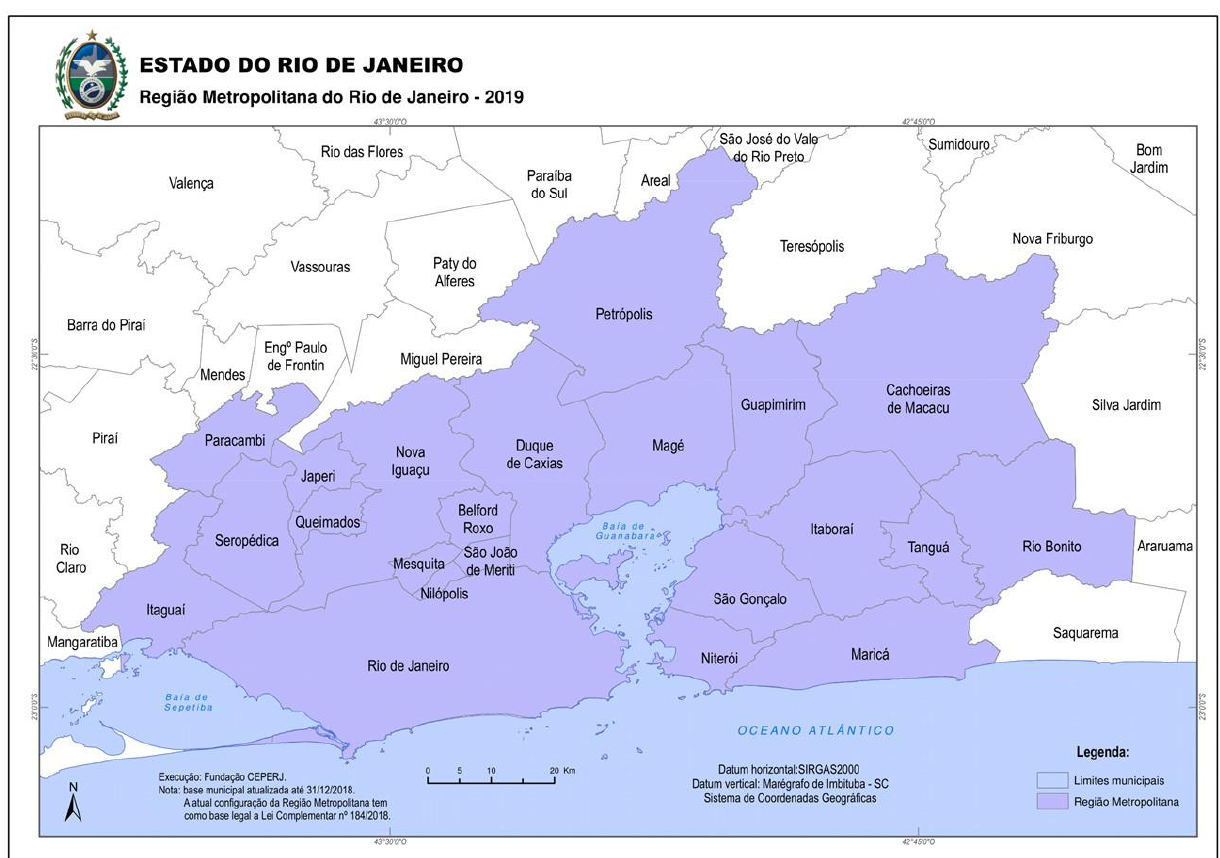
Figure 1. Map of the Metropolitan Region of Rio de Janeiro. Source: Fundação CEPERJ (2019). The figure is in the public domain, produced by the government of the state of Rio de Janeiro. Available at: http://arquivos.proderj.rj.gov.br/sefaz_ceperj_imagens/Arquivos_Ceperj/ceep/informacoes-do-territorio/cartografia-fluminense/Mapa%20da%20Regi%C3%A3o%20Metropolitana%20do%20Rio%20de%20Janeiro%20%E2%80%93%202019%20-%20CEPERJ.pdf, Accessed on 13 April 2023.